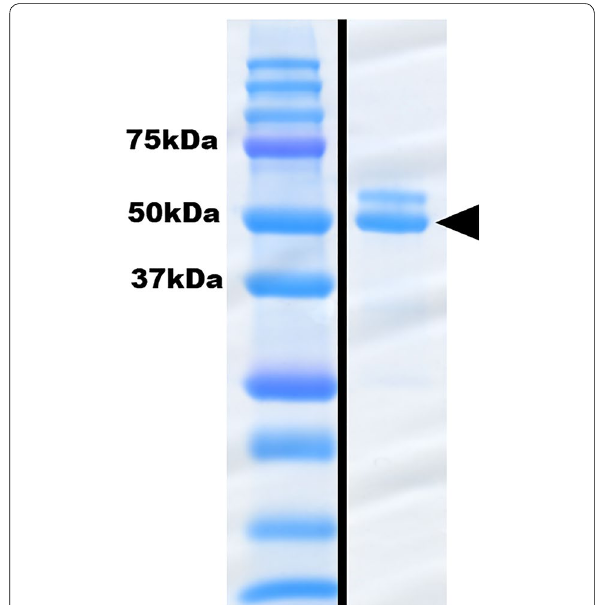
Fig. 1 SDS-PAGE of the purified XPO DUET. The left lane includes the molecular weight marker, while the right lane includes 10 μg of the purified